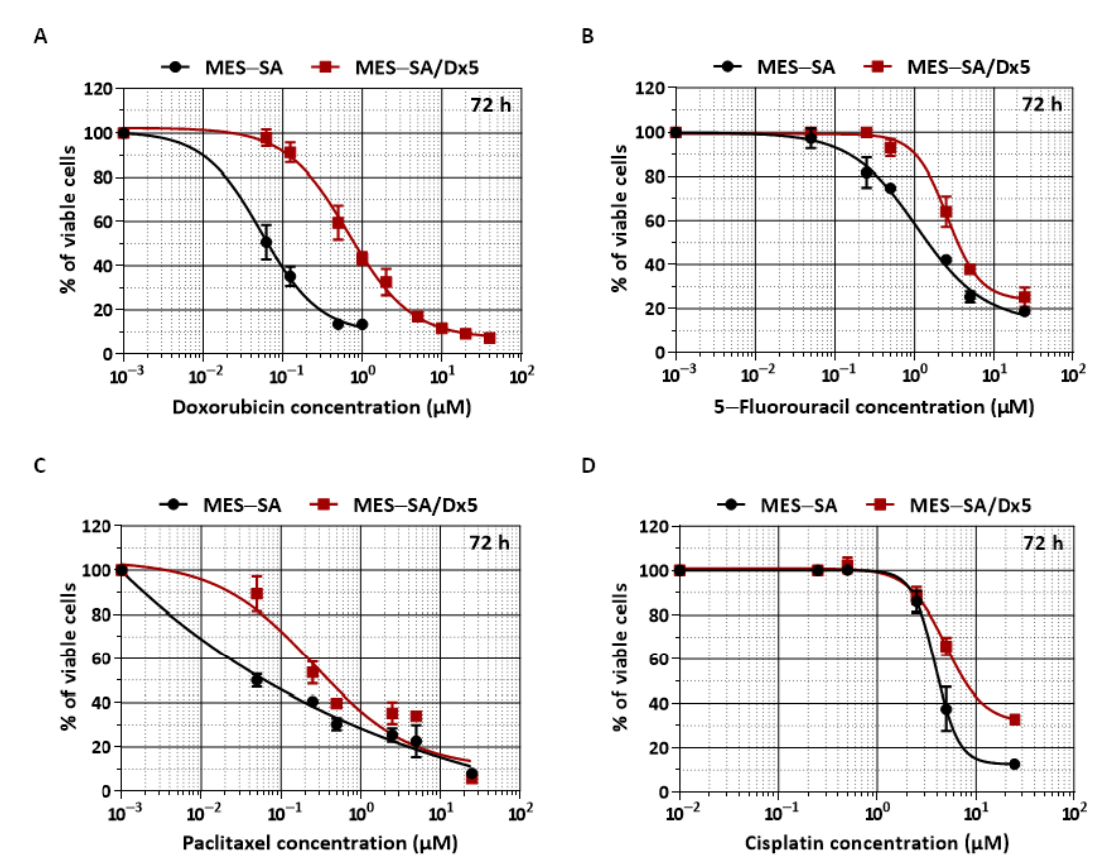
Figure 1. Differential sensitivity of MES-SA and MES-SA/Dx5 cells to various anticancer agents. Growth inhibition of MES- SA and MES-SA/Dx5 cells was determined using the (3-(4,5-dimethylthiazol-2-yl)-2,5-diphenyltetrazolium bromide (MTT) assay after 72 h of exposure to increasing concentrations of doxorubicin ( A ), 5-fluorouracil ( B ), paclitaxel ( C ), and cisplatin ( D ). The results are expressed as a mean percentage of control growth ± Standard Deviation (SD) of three independent experiments.